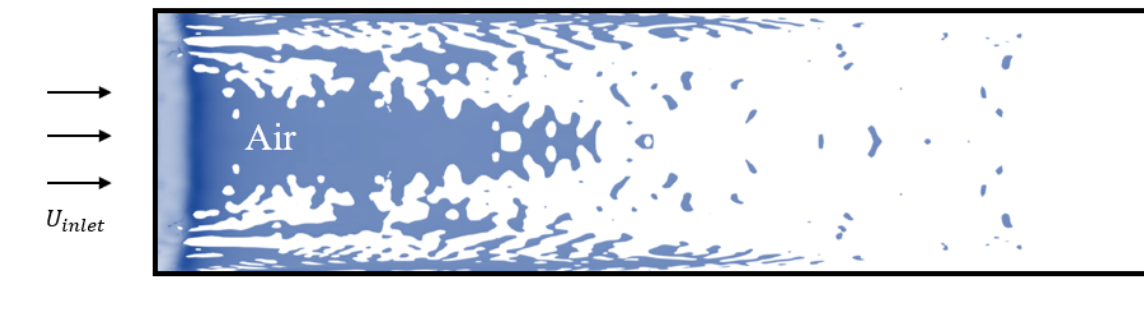
Figure 15. Air layer shape according to CLSVOF and VOF solvers at C q = 0.037.